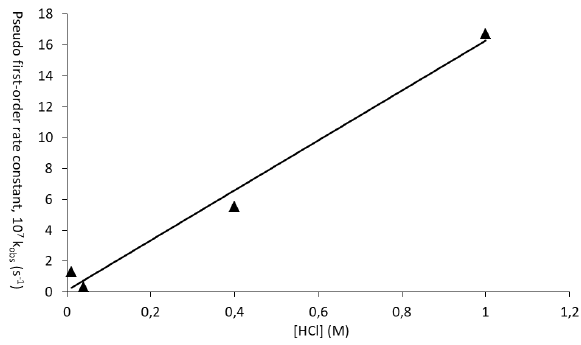
versus [HCl] for obs at 60°C. The solid line is 2